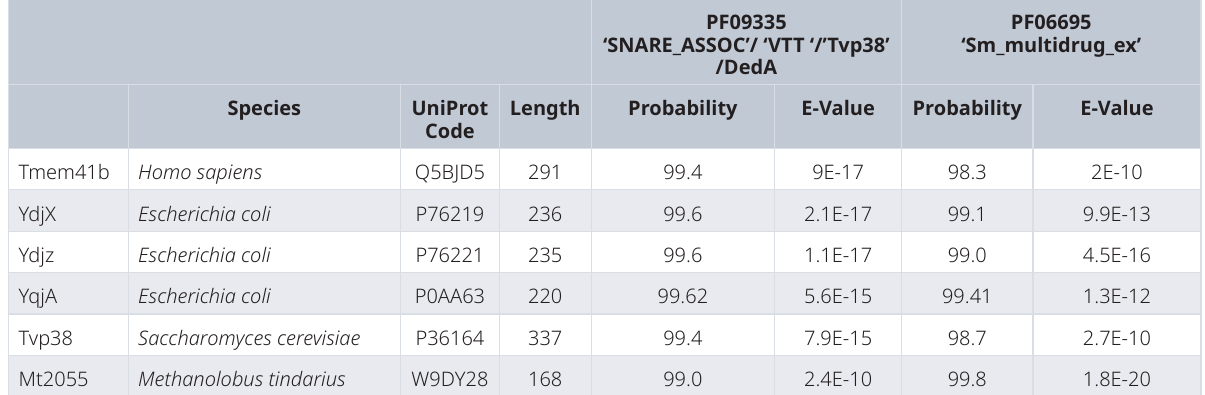
Table 1. HHpred results for Tmem41b and homologues demonstrate homology between Pfam families PF09335 and